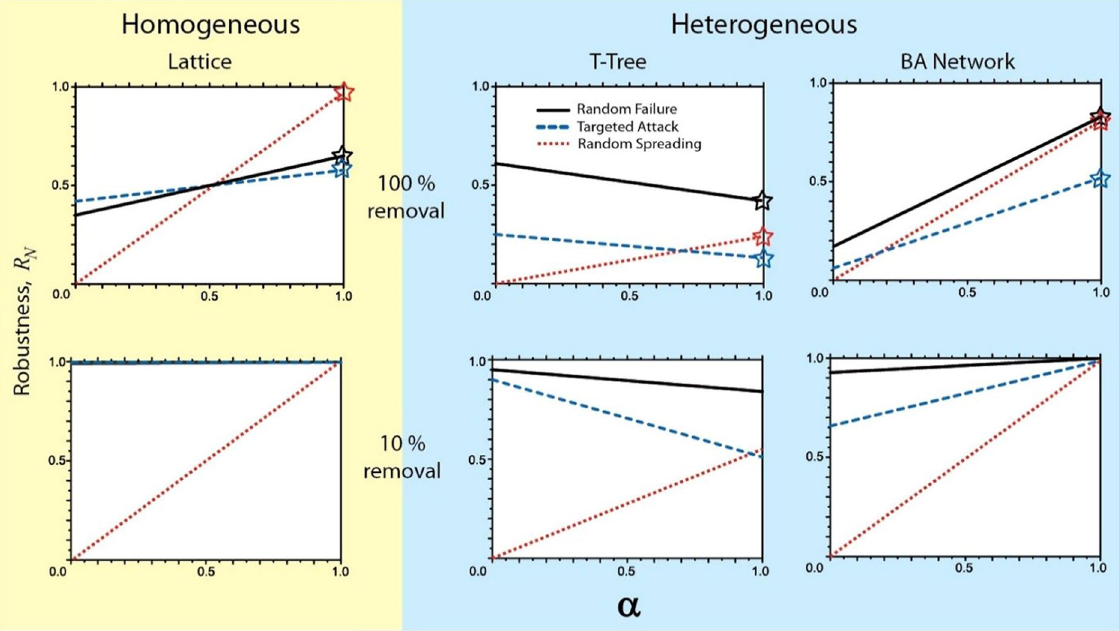
Figure 3. Robustness, R N , as a function of the relative weight given to the connectivity of the Active Network (AN), α . The robustness defined exclusively in terms of the AN ( α = 1) is shown by stars. For the top panels, the robustness of a homogeneous network subject to any attack and heterogeneous networks under random failure, is equal to 0.5 for α = 0.5 due to the property E A + E I ≈ 1. For all cases, notice (i) a strong dependence of robustness on α , (ii) robustness crossovers –changes in ranking (ordering of respective R N values) of different attack strategies depending on α and (iii) shift of the robustness crossovers towards α = 1 with substantial divergence in the attack strategies when the system is evaluated not at the time of complete destruction but at its early stages of attack (bottom